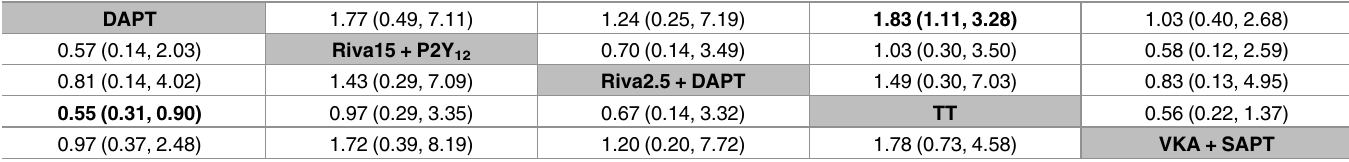
Table 3. NMA results of major bleeding risk for all treatments relative to each other under the consistency model.